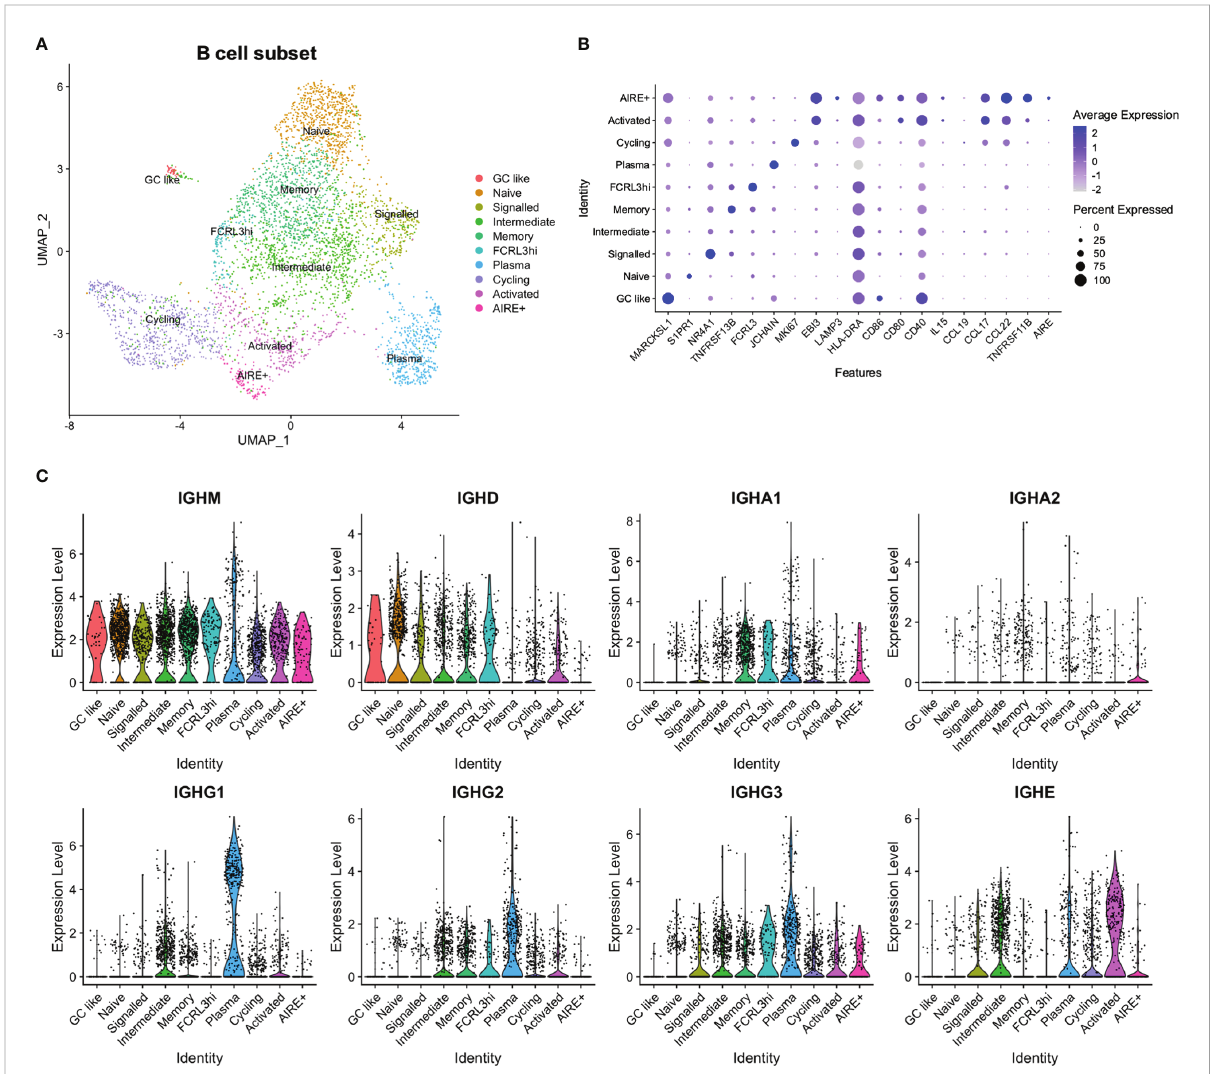
FIGURE 4 Reanalysis of B cell subset. (A) UMAP of B cell subset. (B) Expression of selected genes in B cell subset. (C) Expression of immunoglobulin genes in B cell